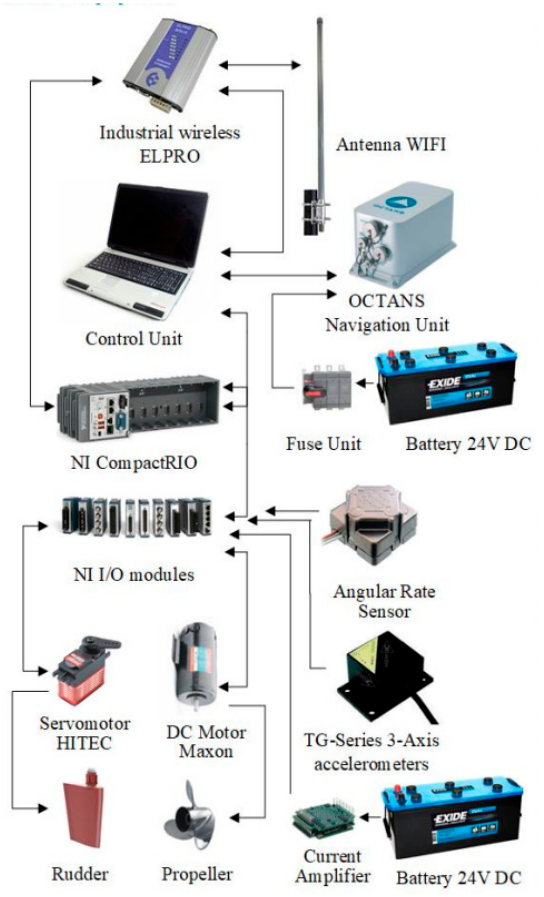
Figure 4. Sensors and actuators used in the free-running ship model.